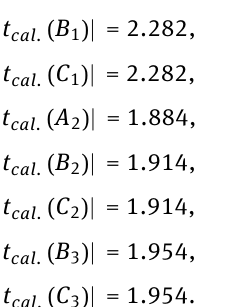
1; 2; 3 denote the approximate solution of Eq. (11), (19) and (27) via AHPSTM, DTM and HPM, respectively. The considered degree of freedom is n the tabulated value of t at α = 5% is | t culated values of test statistic of Eq. (11), (19) and (27) for pair AHPSTM with exact solution A lution B ; and HPM with exact solution C i given